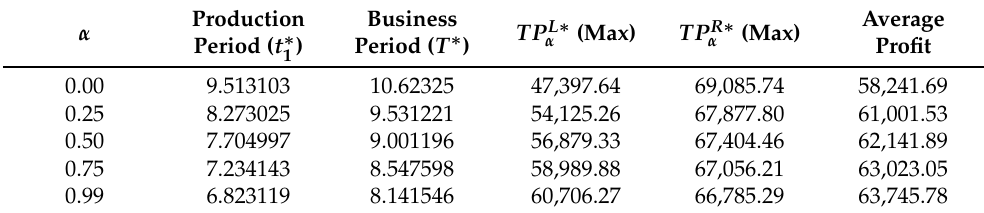
Table 13. Optimum results of Example 4 for maximizing both TP L α and TP R α